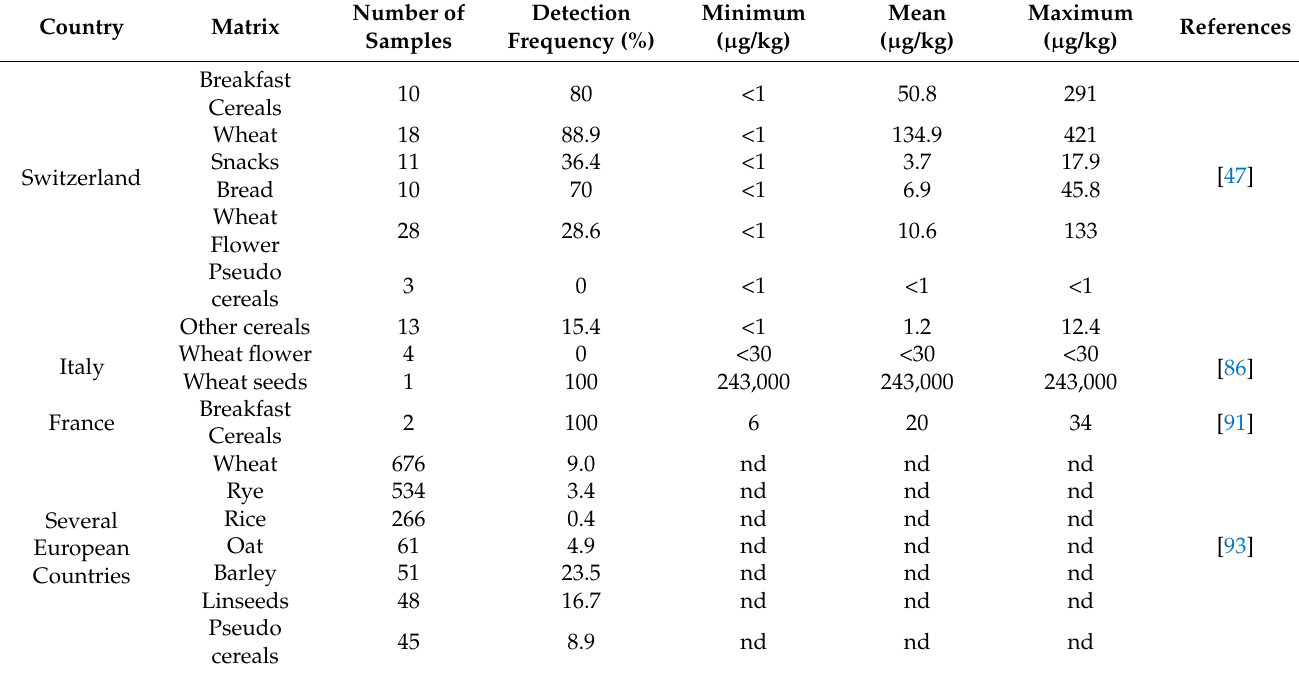
Table 6. Occurrence of glyphosate in cereals and cereal products.